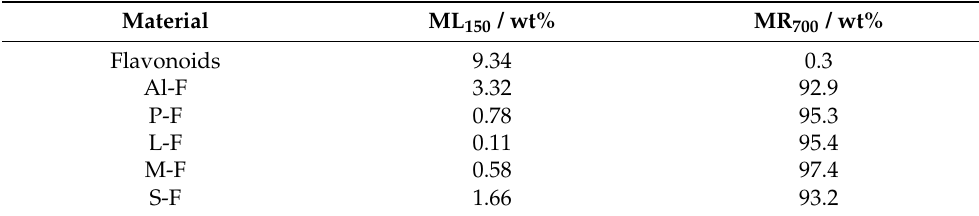
Table 5. Thermogravimetric parameters for flavonoids and hybrid nanomaterials.